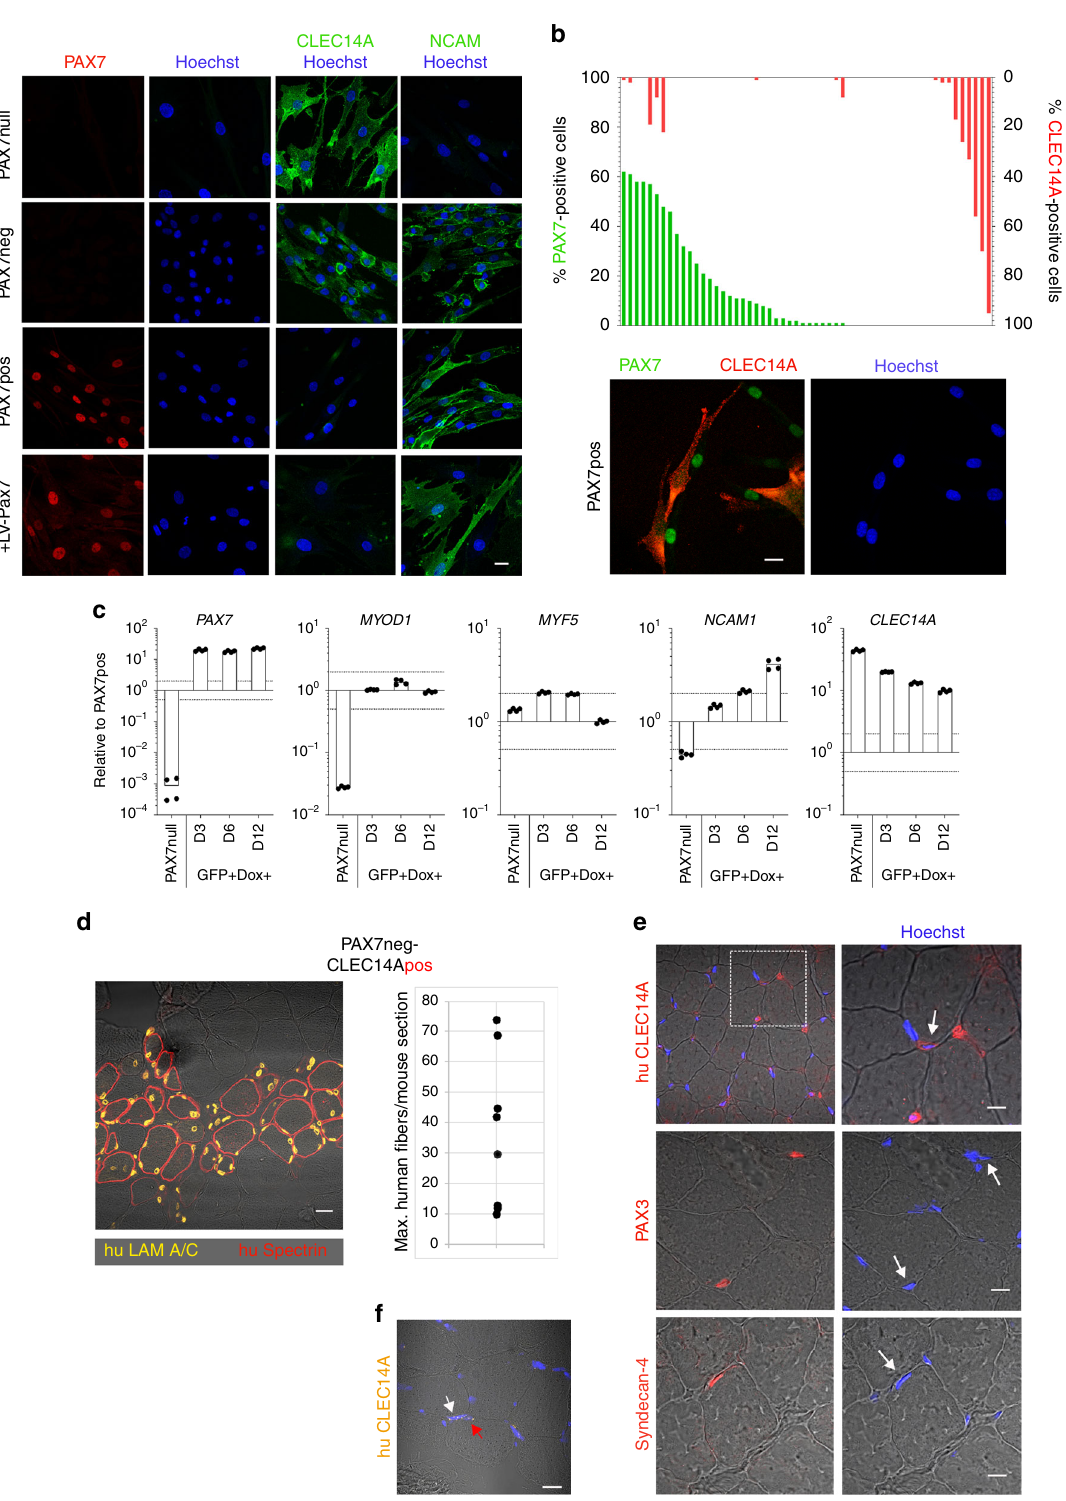
patterning, indicating that all muscles had formed in develop- ment. Pax genes are crucial for organogenesis, and Pax3 is the only other member of the gene family co-expressed with Pax7 in myogenic cells. PAX3 mutations in Klein – Waardenburg syn- drome lead to distal muscle defects 19 , whereas a PAX7 null mutation, as shown here, predominantly affects axial muscle raising the question as to whether these genes are differentially